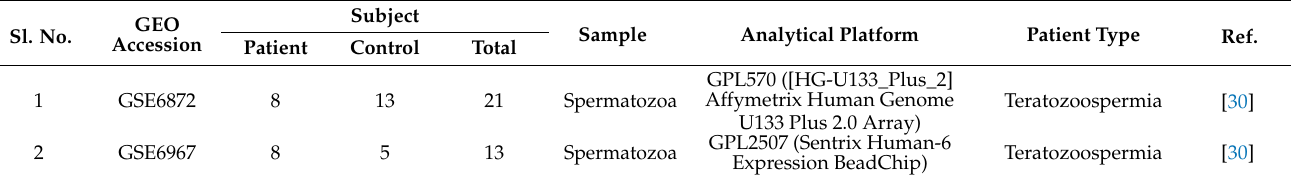
Table 1. List of microarray datasets included in the study obtained from the National Center for Biotechnology Information-Gene Expression Omnibus (NCBI-GEO) database for teratozoospermia and